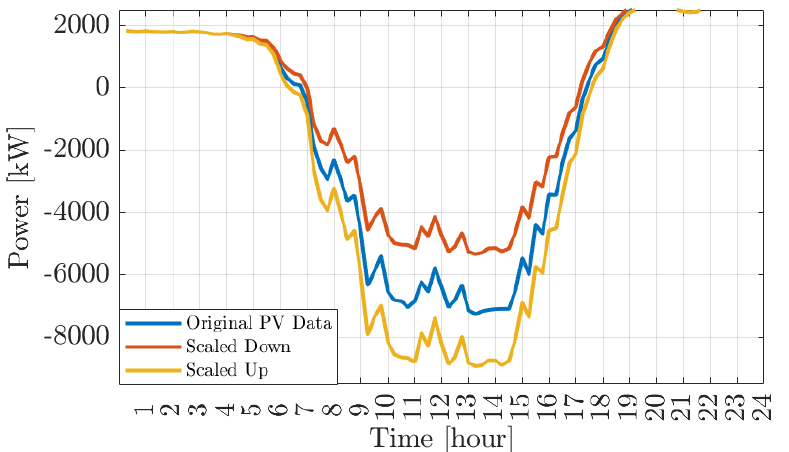
Figure 18. Dispatch plan with scaled PV generation time series and re-trained RL